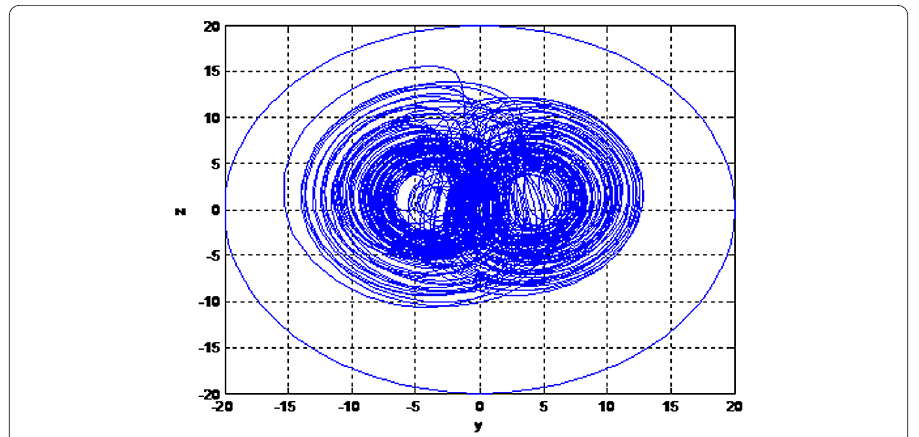
Figure 5 Localization of chaotic attractor of system (2) by (cid:3) with a = 5, b = 20, c = 1, d = 0.1, k = 0.1, e = 20.6, h = 1 and the initial state ( x 0 , y 0 , z 0 , w 0 ) =